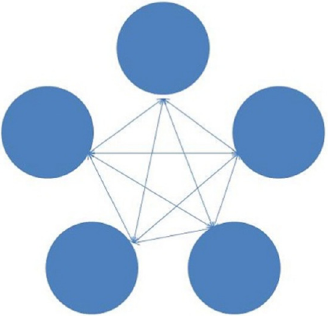
Figure 1. Modern computing systems are constructed as a set of autonomous modules that can interact with each other in various sophisticated